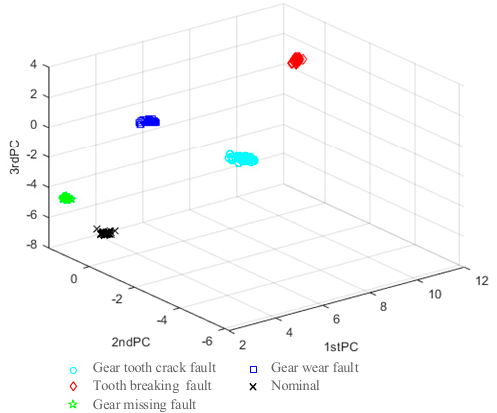
Figure 9. Clustering result of gear fault features under condition 3.